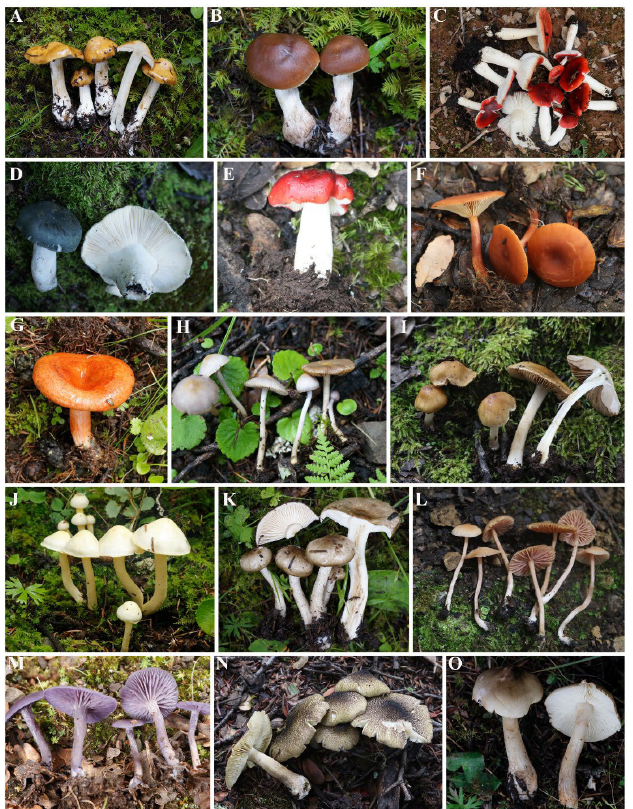
Figure 4. Photos of dominant genera. ( A ) Cortinarius aurantionapus ; ( B ) C. illuminus ; ( C ) Russula cf. emetica ; ( D ) R. cf. faustiana ; ( E ) R. cf. emetica ; ( F ) Lactarius alpinihirtipes ; ( G ) L. aurantiosordidus ; ( H )